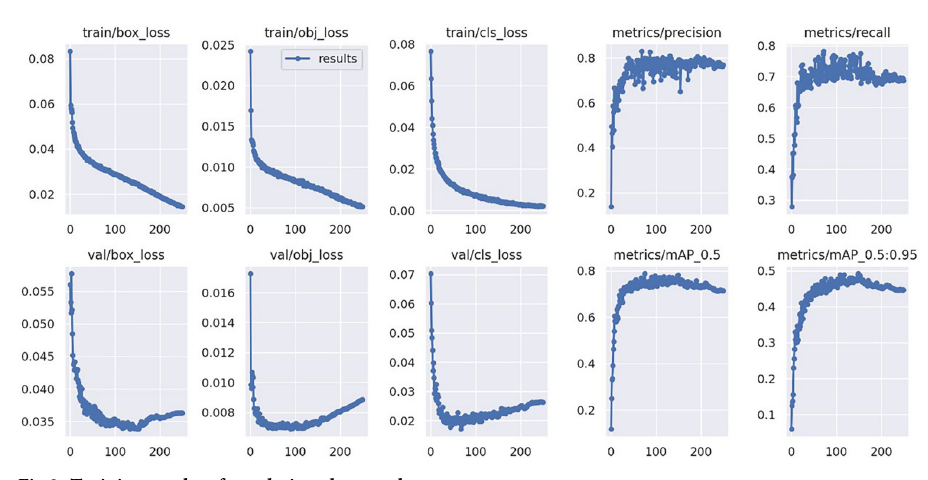
Fig 8. Training results of our designed network.